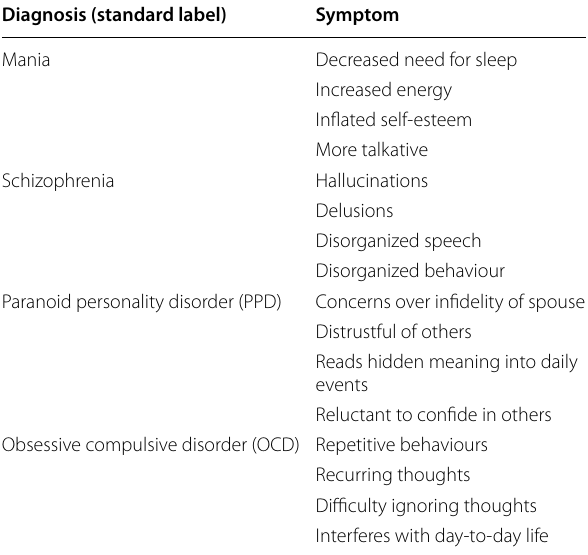
Table 1 Medical diagnoses and symptoms used, adapted from Young et al., (2007,